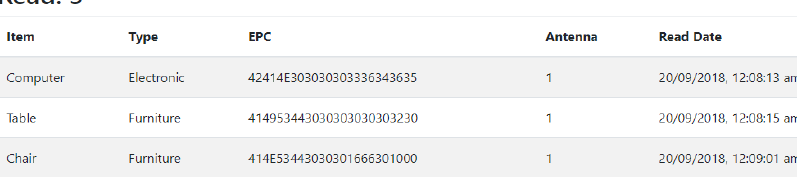
Figure 6. Front-end application presenting the physical objects identified.